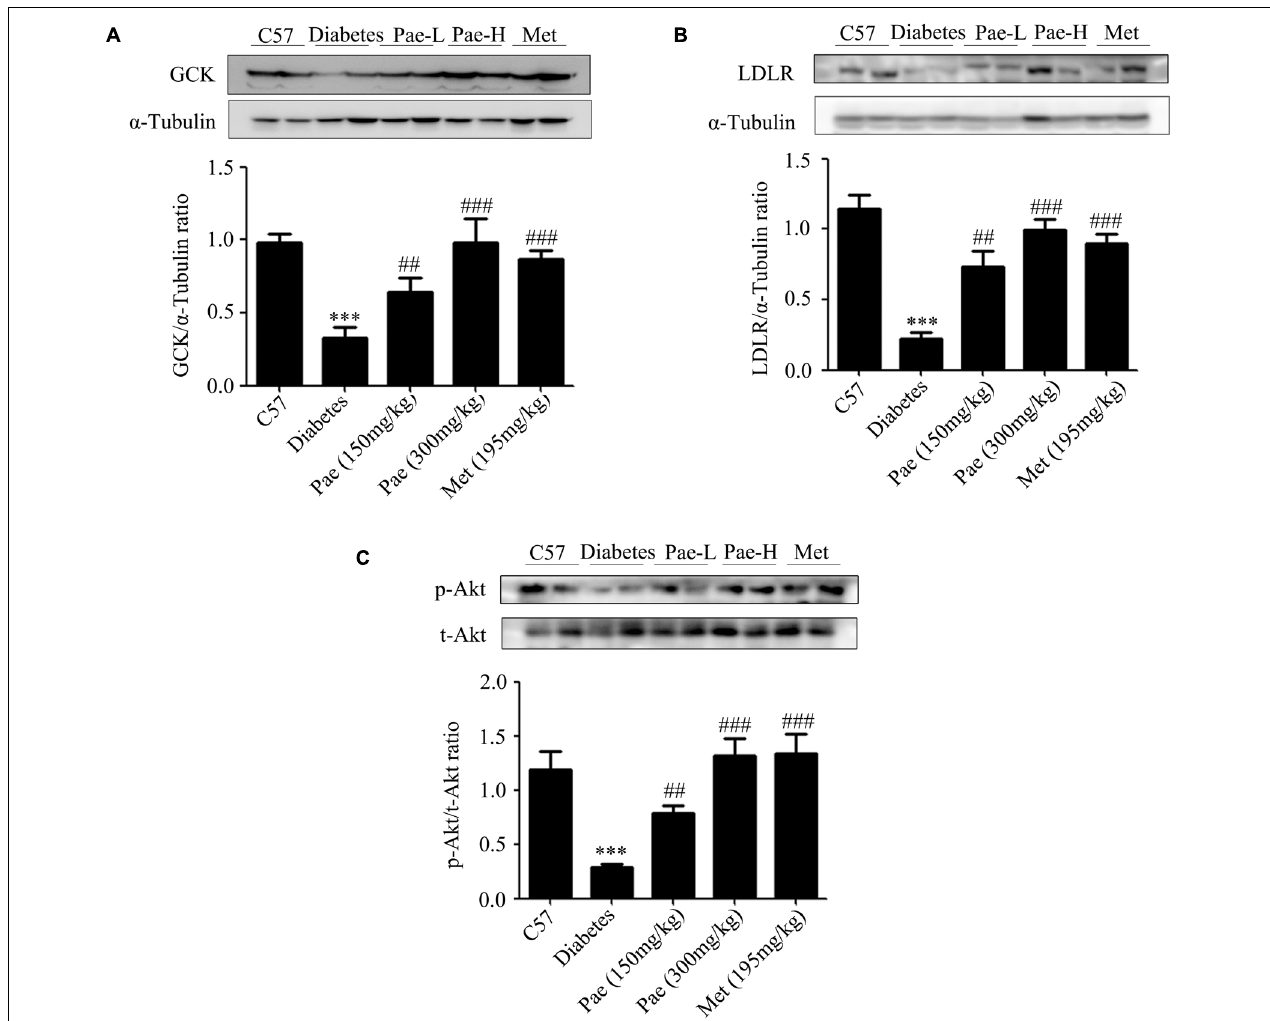
FIGURE 2 | Paeonol upregulated the protein levels of GCK and LDLR and enhanced Akt phosphorylation in animals. (A–C) The protein expressions of GCK and LDLR and the phosphorylation level of Akt were measured by western blot analysis ( n = 6–8). All experiments were performed at least three times with similar results. ∗∗∗ p < 0.001 vs. C57; ## p < 0.01 and ### p < 0.001 vs.